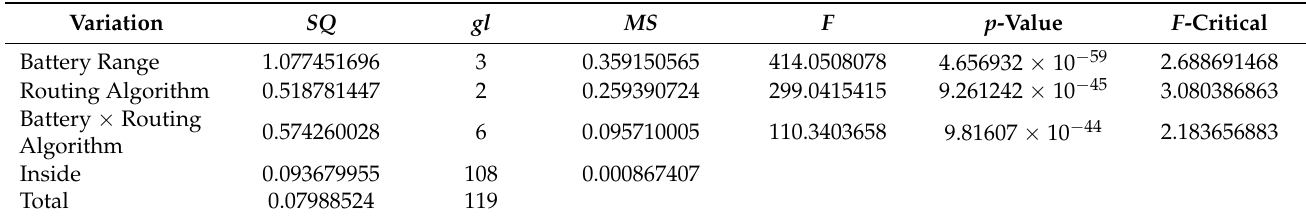
Table 10. Analysis of variance vs. delivery rate in Reality